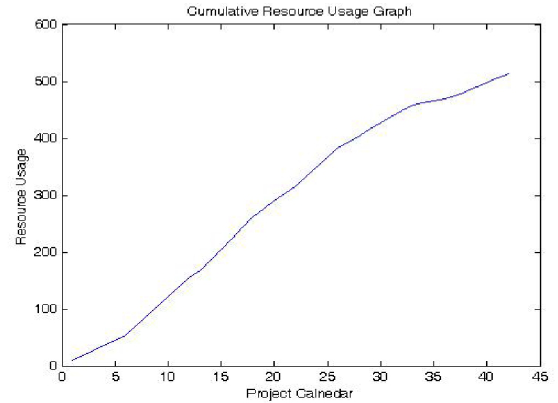
Figure 12. Cumulative resource usage for resource 2 of experiment 1 (relaxed resource constraint)